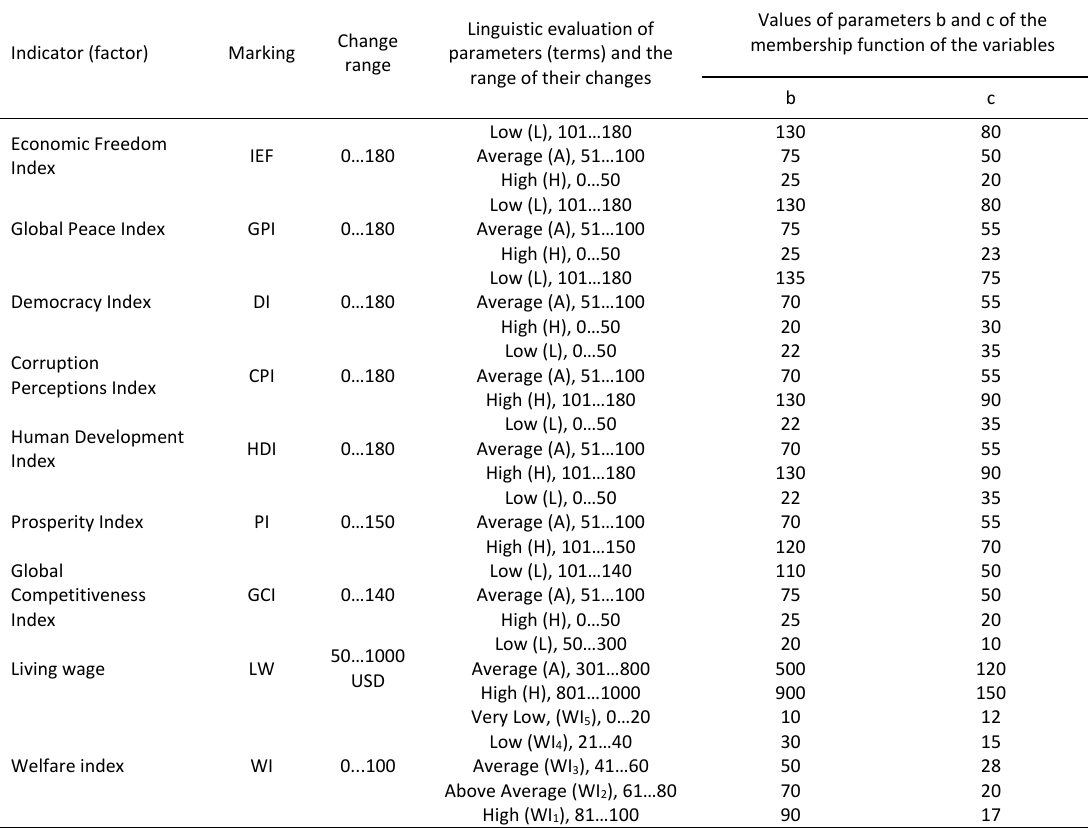
Table 2: Generalized values of indicators of the model of estimation of level of public welfare of Ukraine Linguistic evaluation of Change Indicator (factor) Marking parameters (terms) and the range range of their changes